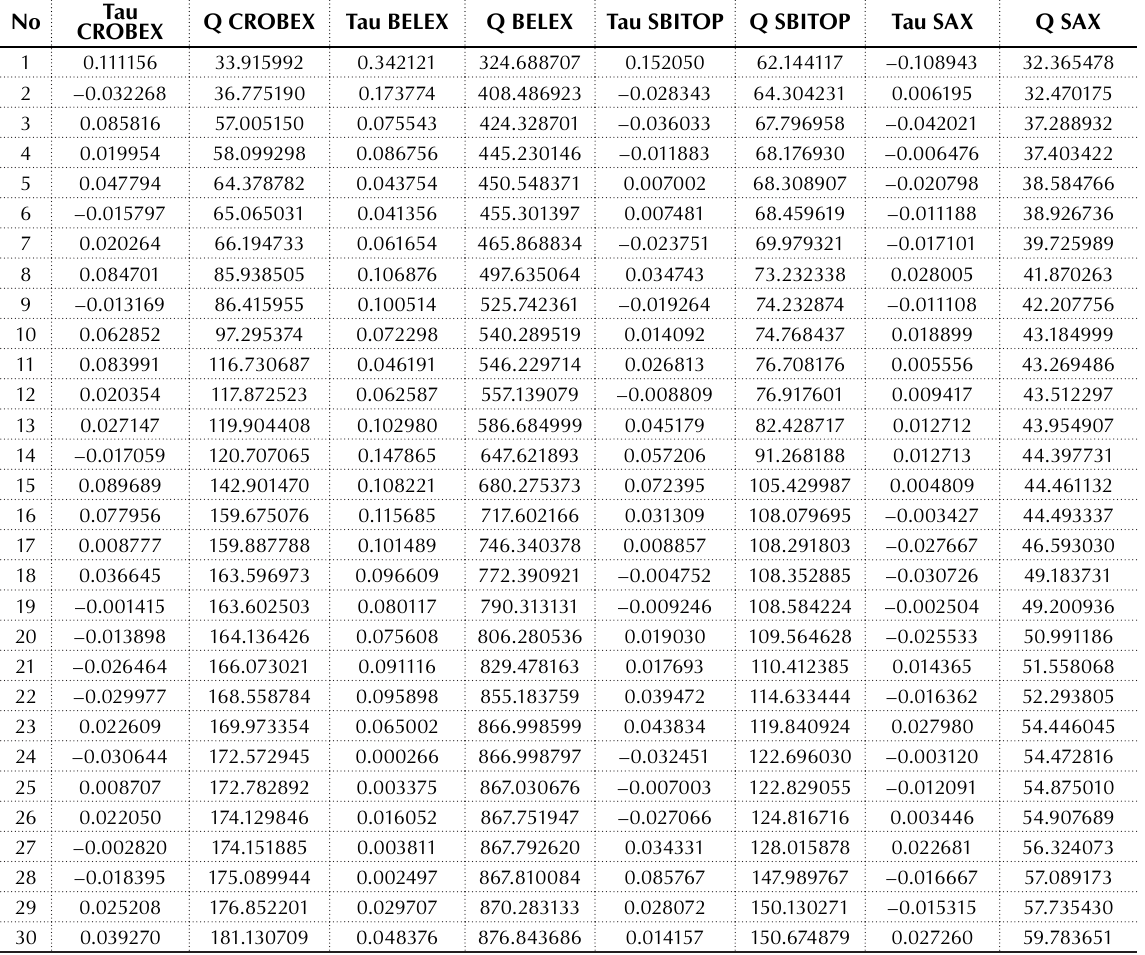
Table 1. Correlation coefficients in serial correlation